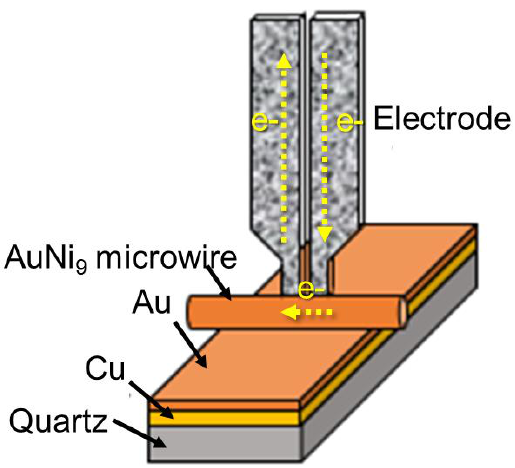
Figure 1. The welding installation and welding structure of an AuNi 9 microwire and Au microlayer.